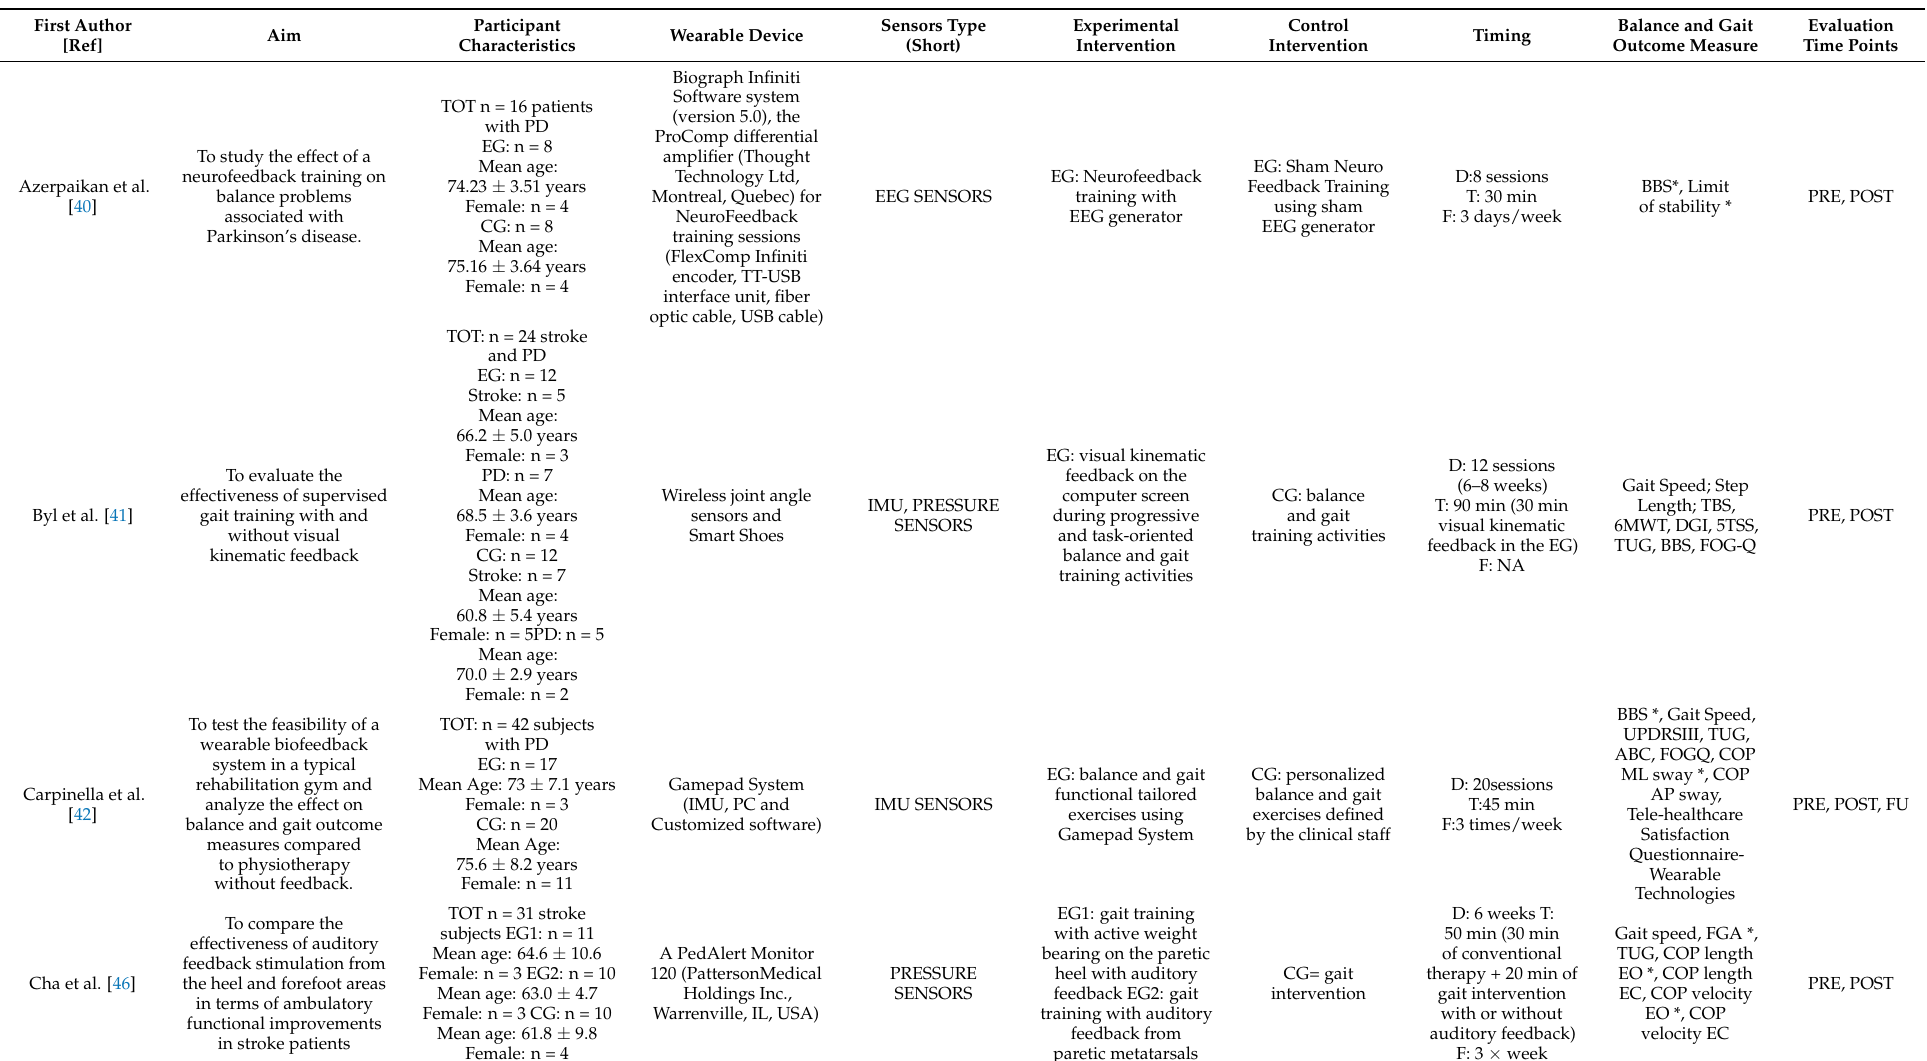
Table 2. Characteristics of included